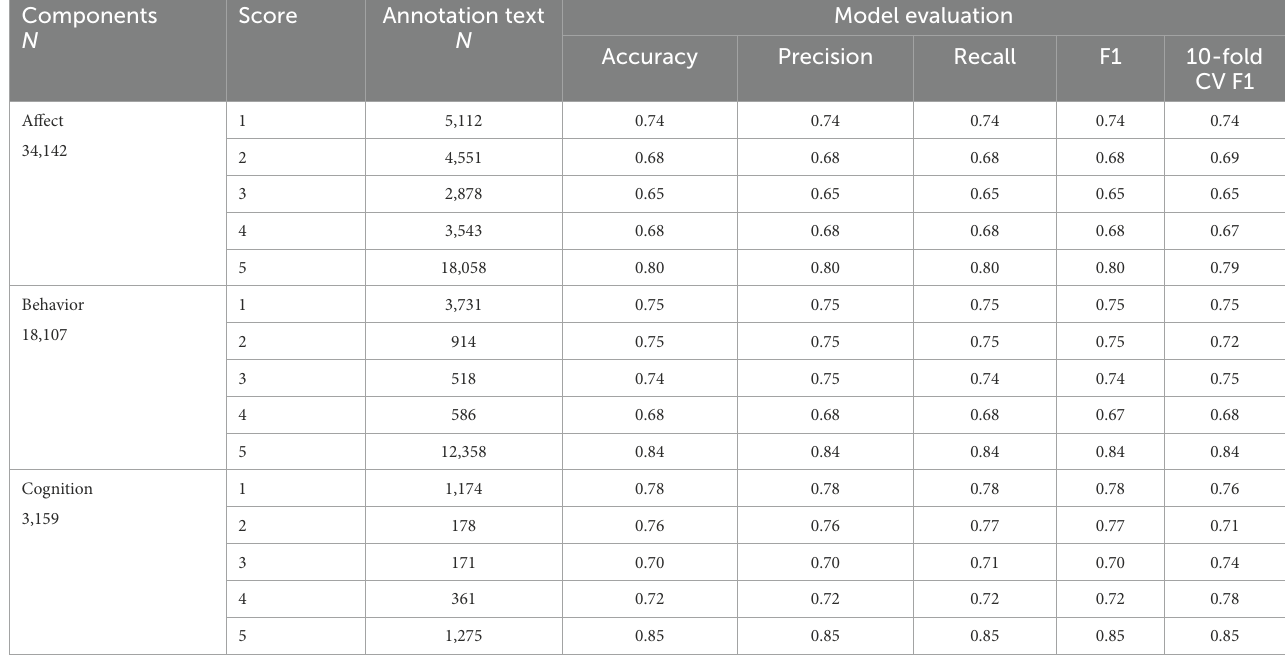
TABLE 1 Manual annotation of training and testing text and performance of linear SVMs model. Components